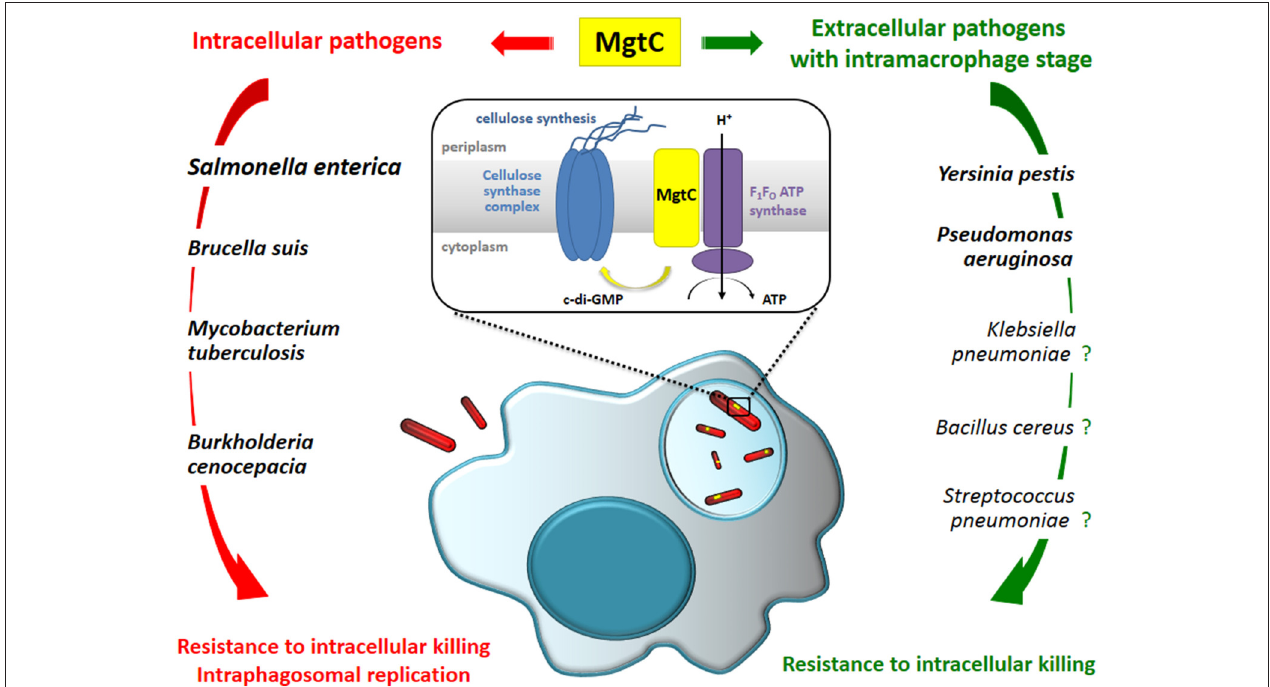
FIGURE 1 | MgtC promotes an intramacrophage phase in intracellular and so-called extracellular pathogens and may be considered as a clue to reveal bacterial pathogens adapted to an intramacrophage stage. The contribution of MgtC for intramacrophage survival/replication has been demonstrated experimentally for several pathogens indicated in bold. We propose that it may also play an intramacrophage role in several other bacterial pathogens as K. pneumonia , B. cereus, and S. pneumoniae . Expression of mgtC gene has been shown to be induced inside macrophages in S. enterica and P. aeruginosa . Based on the analysis of the Salmonella protein, MgtC’s role in macrophage has been linked to the modulation of F 1 F o ATP synthase activity and to the repression of cellulose production. It is however unknown how this function is conserved for other MgtC proteins that play a role in